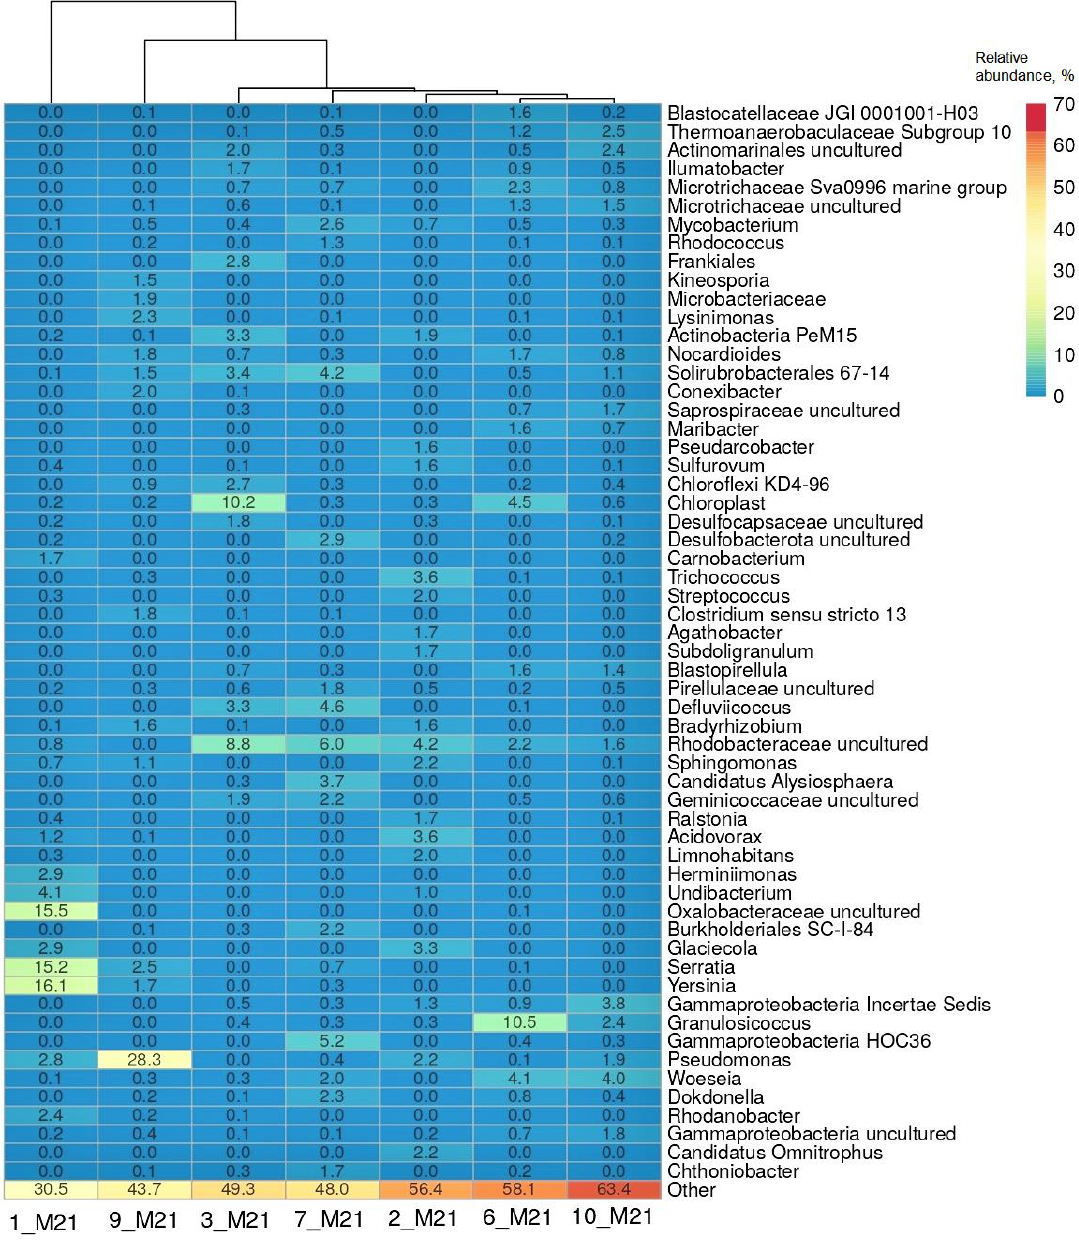
Figure 3. Heatmap of distribution of the genera with the highest relative abundance in the libraries of the 16S rRNA gene sequences from seawater, littoral, and coastal soil samples. Representation of the genus was calculated as sequence proportions divided by total sequence count in each library. Columns are clustered using correlation distance and average